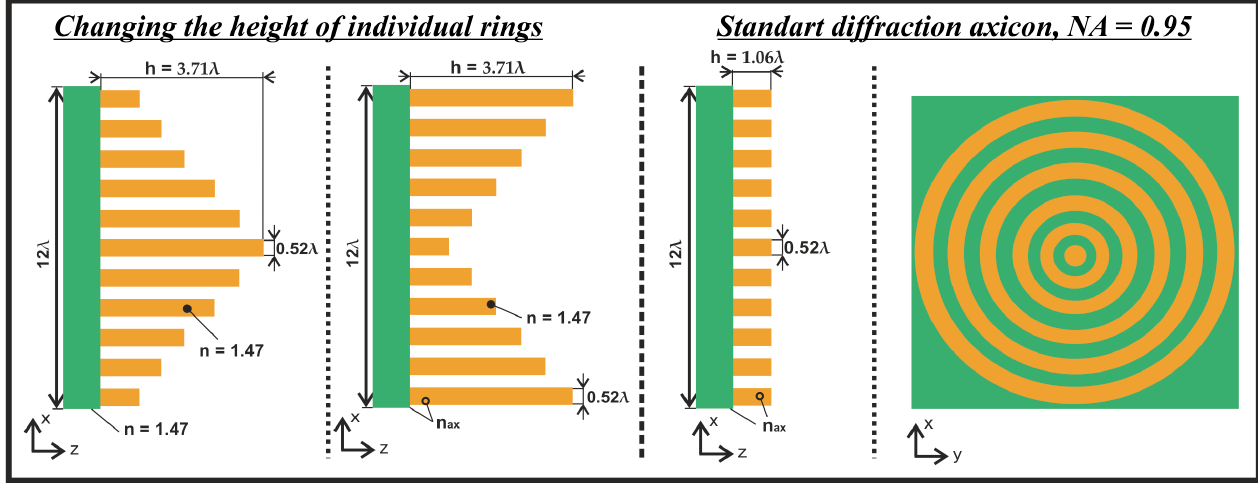
Figure 3. Cross sections of the studied 3D microstructures with a standard substrate in xz and xy planes.